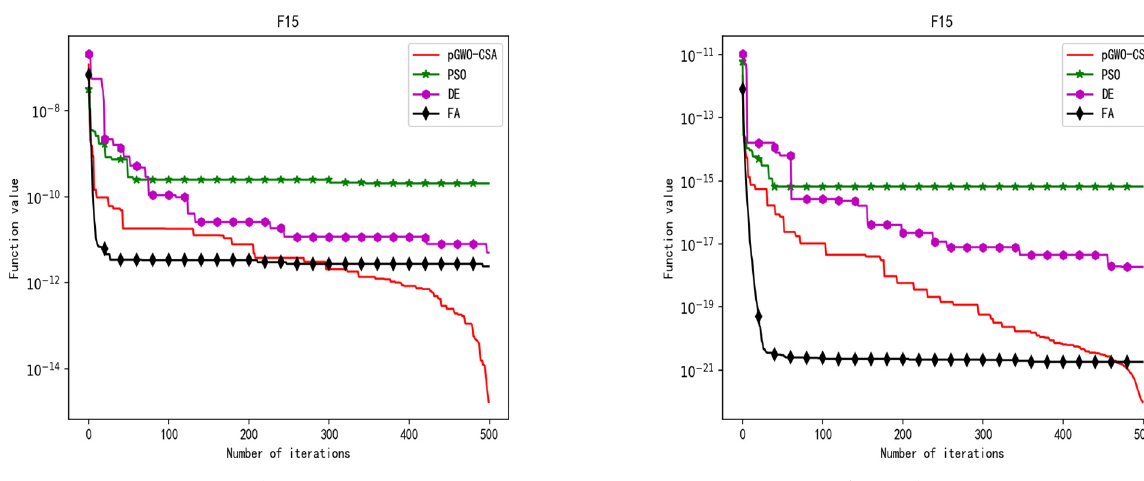
Figure 19. Convergence curve of test function F15.